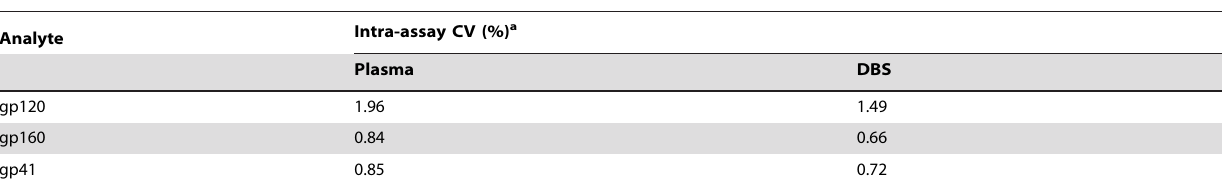
Table 1. Intra-assay variability.